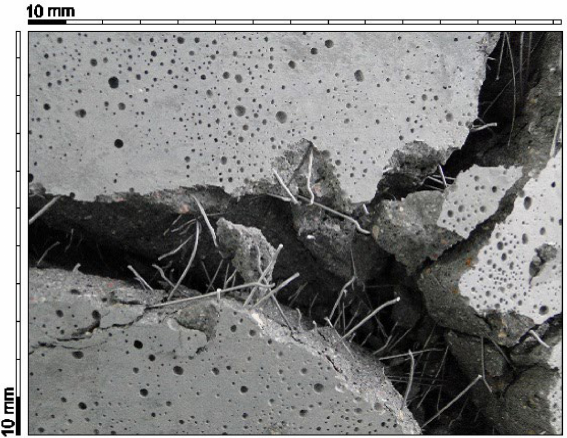
Figure 12. The view of the “pulled” fibers from the fiber composite matrix in a slab damaged after